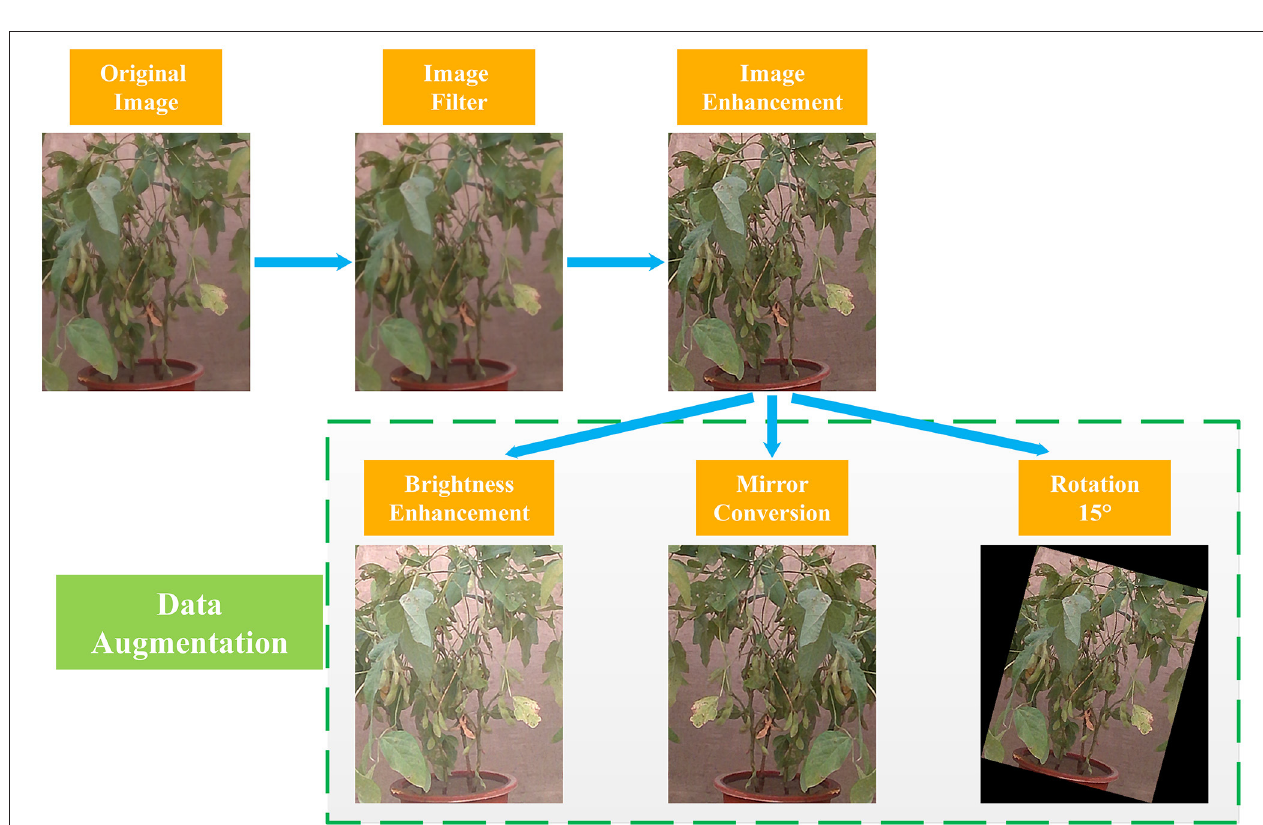
FIGURE 3 | Image processing